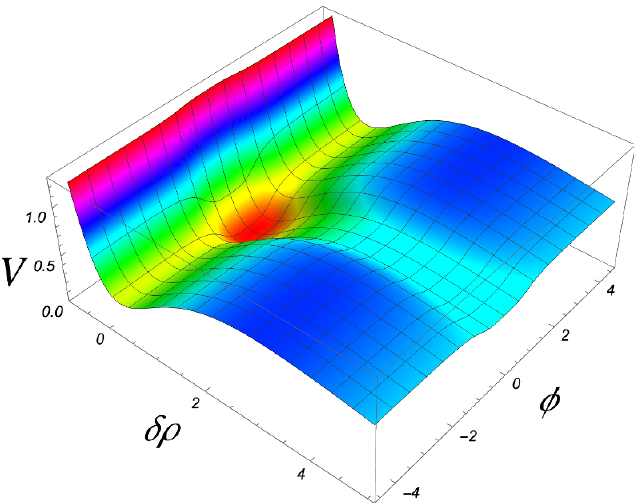
Figure 7 . The potential of the volume modulus (cid:14)(cid:26) and the in(cid:13)aton (cid:30) in KKLT case, (6.8), (6.9). V inf is chosen to be the form V inf = V 0 (1 + (cid:22) 4 ) (cid:0) 1 . In(cid:13)ation is realized along the straight valley of (cid:30) 4 the (cid:30) direction, while the volume (cid:14)(cid:26) is stabilized. In realistic models one should take V 0 10 (cid:0) 10 ; (cid:24) here we took V 0 = 1 just for illustration. The shape of the potential along the in(cid:13)ationary